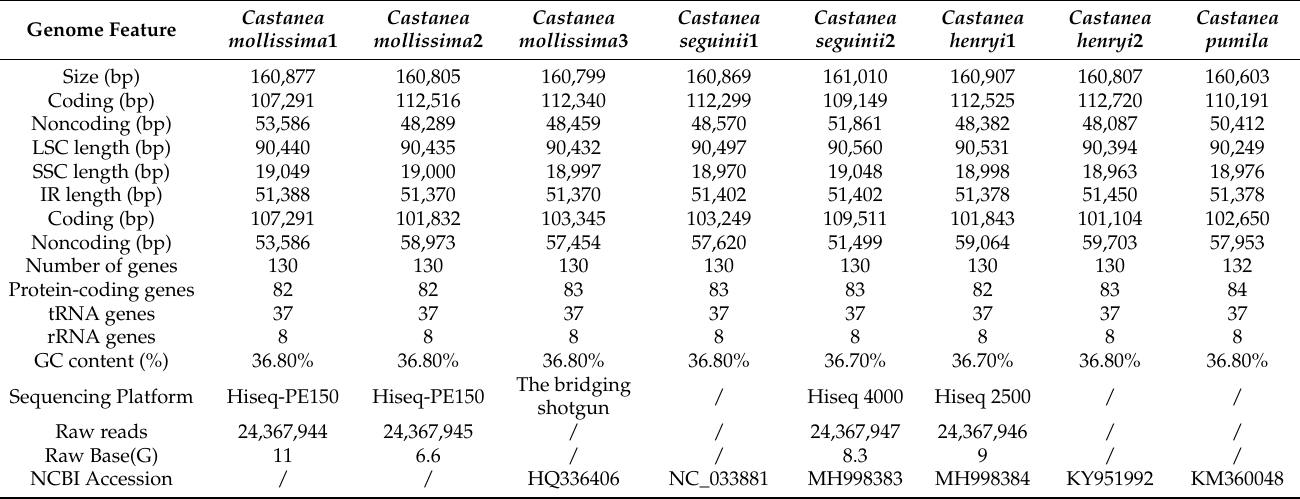
Table 1. Summary statistics for eight Castanea cp genomes.